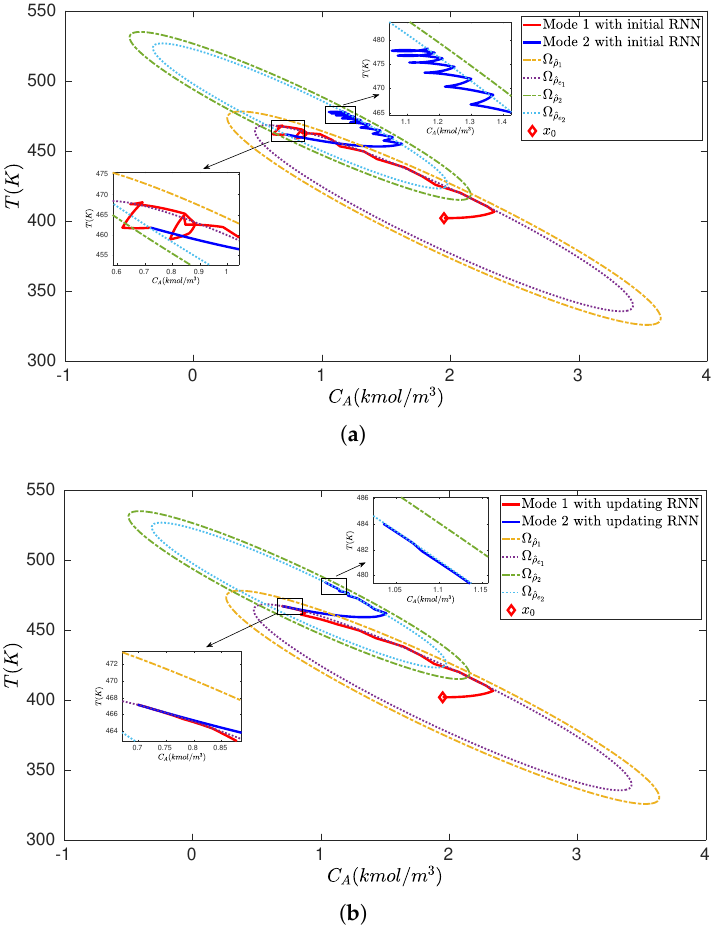
Figure 2. Closed–loop state trajectories ( C A , T ) for the uncertain CSTR system operating in mode 1 for t ∈ [ 0, 0.25 h) (red solid line) and switching to mode 2 at t = 0.25 h (blue solid line) under the RNN-LEMPC of Equation (26), ( a ) using the initial offline-learning RNNs at all times, and ( b ) using the online updating RNNs, for the initial condition ( C A , T ) = (1.95 kmol/m 3 402 K) (marked as red diamond).